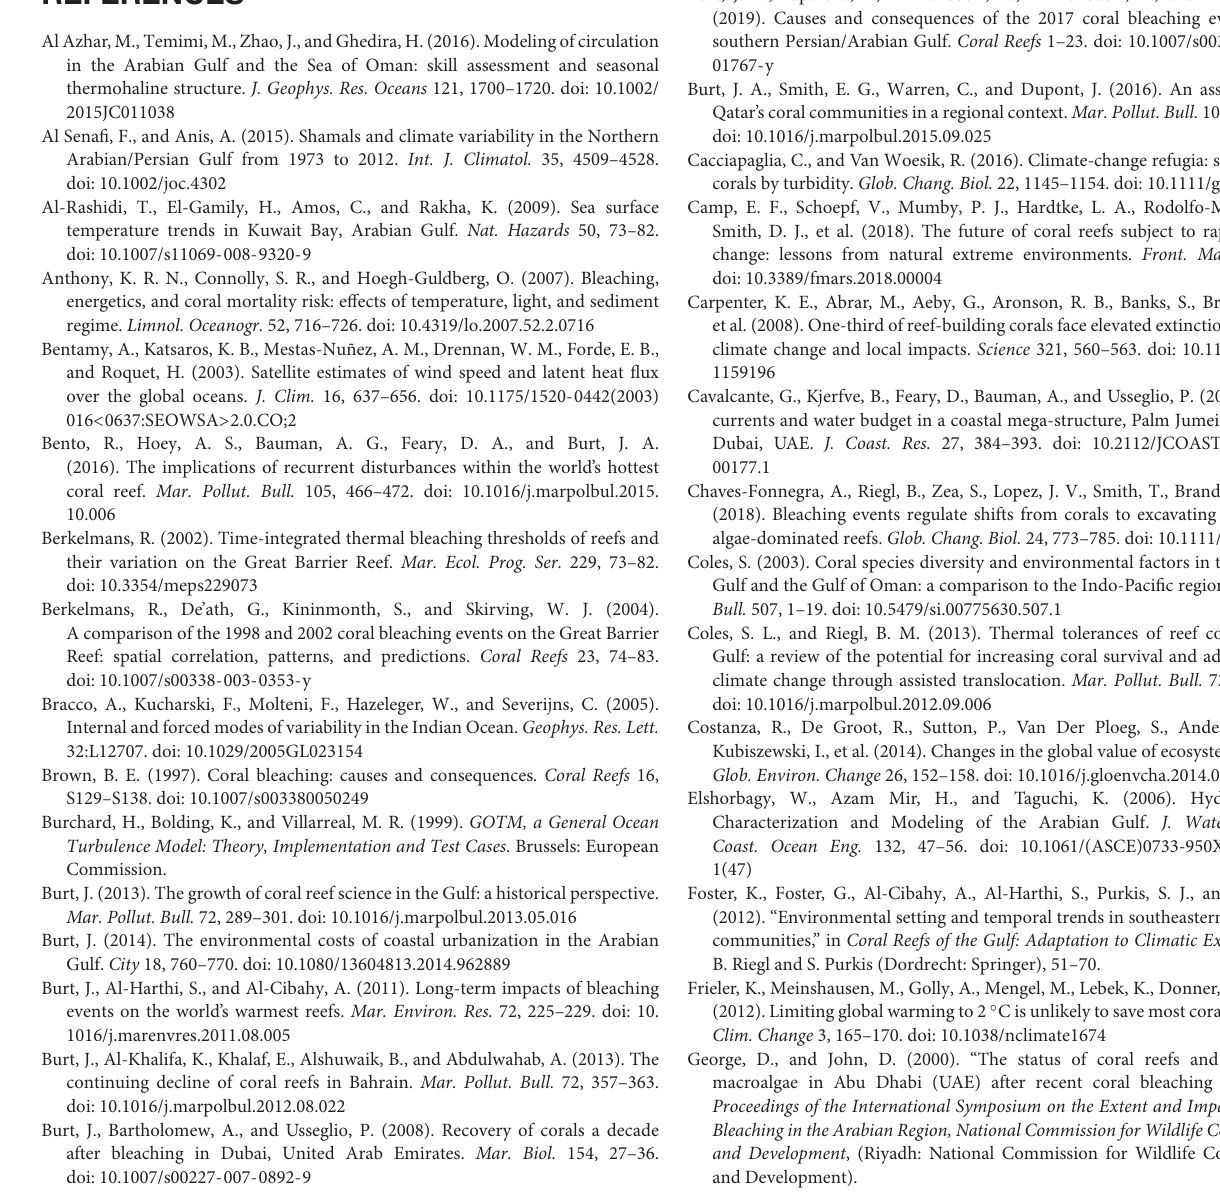
FIGURE S4 | Sea-bottom temperature, wind speed and direction and sea-surface heat fluxes in July and August 2012 to 2017 at Ras Ghanada. Top panels: simulated (blue) and observed (green) daily averaged bottom temperature (left scale) and daily averaged wind speed (right scale); the level corresponding to the 34.35 ◦ C coral bleaching threshold has been highlighted for visual reference. Mid panels: hourly direction from which the wind blows. Bottom panels: daily averaged sensible (cyan), infrared (black), and latent (purple) heat fluxes at the sea surface. FIGURE S5 | Sea-bottom temperature, wind speed and direction and sea-surface heat fluxes in July and August 2012 to 2017 at Dhabiya. Top panels: simulated (blue) and observed (green) daily averaged bottom temperature (left scale) and daily averaged wind speed (right scale); the level corresponding to an estimated 34.5 ◦ C coral bleaching threshold has been highlighted for visual reference. Mid panels: hourly direction from which the wind blows. Bottom panels: daily averaged sensible (cyan), infrared (black), and latent (purple) heat fluxes at the sea surface.